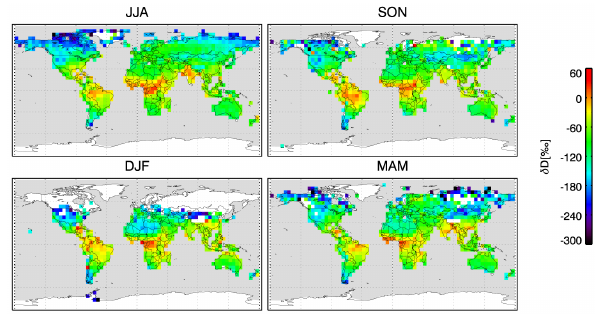
Fig. 14. Seasonal averages in δ D from quality-filtered GOSAT re- trievals between June 2009 to May 2010 binned into 5 ◦ × 5 ◦ .